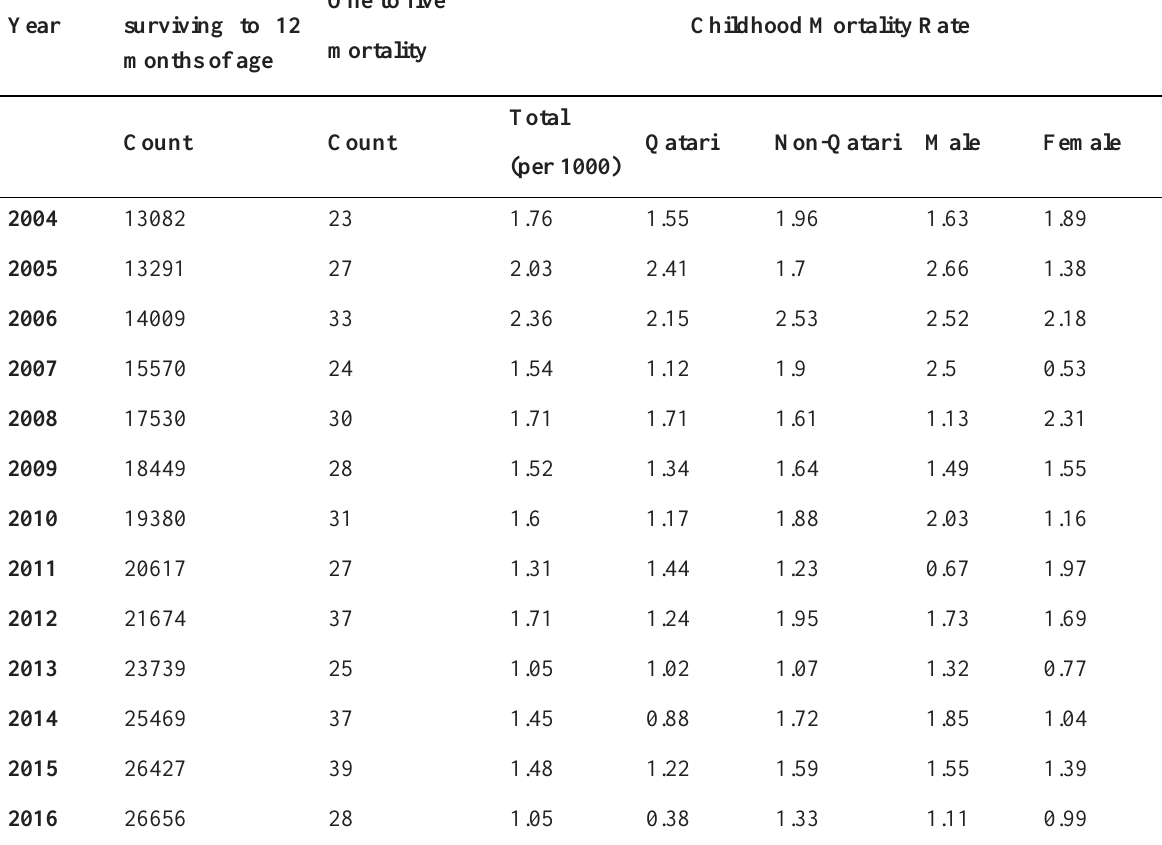
Table 1. Childhood mortality rates by year, sex and nationality Despite the fact that global mortality rates have Childhood mortality (defined as death between the first been decreasing over the past few decades, there is a and the fifth birthday) was approximately 13.3 per 1000 focus on further reduction of under-five mortality in live births globally in 2013. 5 Childhood mortality in the North Africa/Middle East region and Qatar was some nations. 4 For example, under-five mortality rates ranged from 152 per 1000 live births in Guinea Bissau to approximately 5.4 and 2.1 per 1000 live births 2.3 per 1000 live births in Singapore. 5 In 2013, respectively in 2013. 5 Generally, the sex ratio of male to annualized rates of change from the year 1990 to 2013 female mortality aged between one and five years is ranged from -6.8% to 0.1%. 5 The United Nations’ greater than one, and females tend to have better survival sustainable development goal (SDG) aims to reduce the up to five years when compared to males. In East Asian under-five mortality in all countries to at least as low as countries, there was an increase in sex ratio from 1.02 in 25 per 1,000 live births by 2030. 2 According to the global 1990 to 1.14 in 2012. statistics, over 5.6 million children, or 15,000 every day, died in this age group in 2016, making mortality under five years of age a major public health issue globally. 2